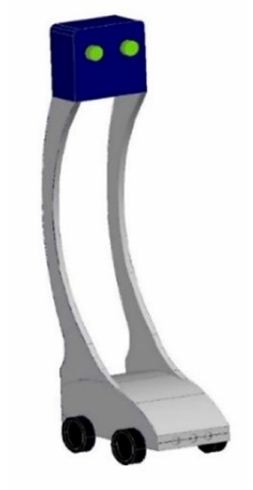
Figure 4. Three-dimensional Model of Telepresence